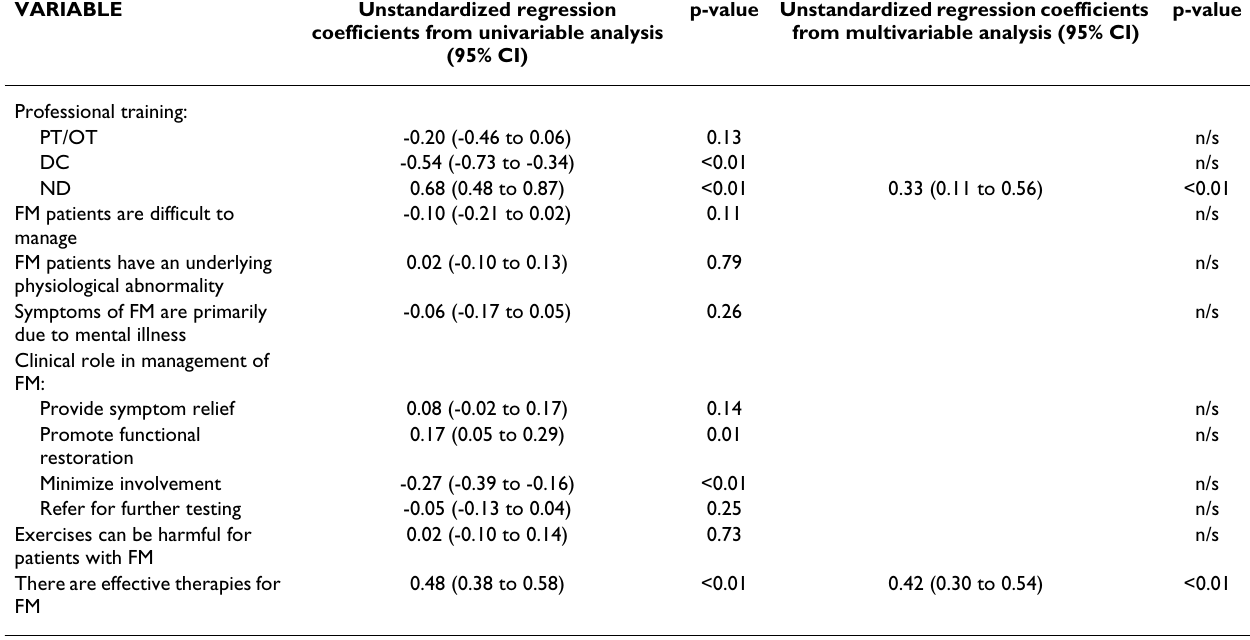
Table 4: Training and beliefs associated with confidence in managing fibromyalgia p-value Unstandardized regression coefficients p-value VARIABLE Unstandardized regression from multivariable analysis (95% CI) coefficients from univariable analysis (95% CI)